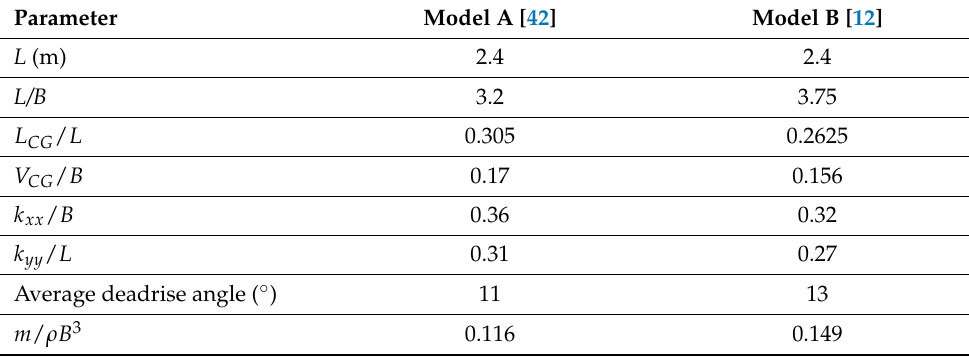
Table 3. Forcing condition of the first set of numerical experiments.